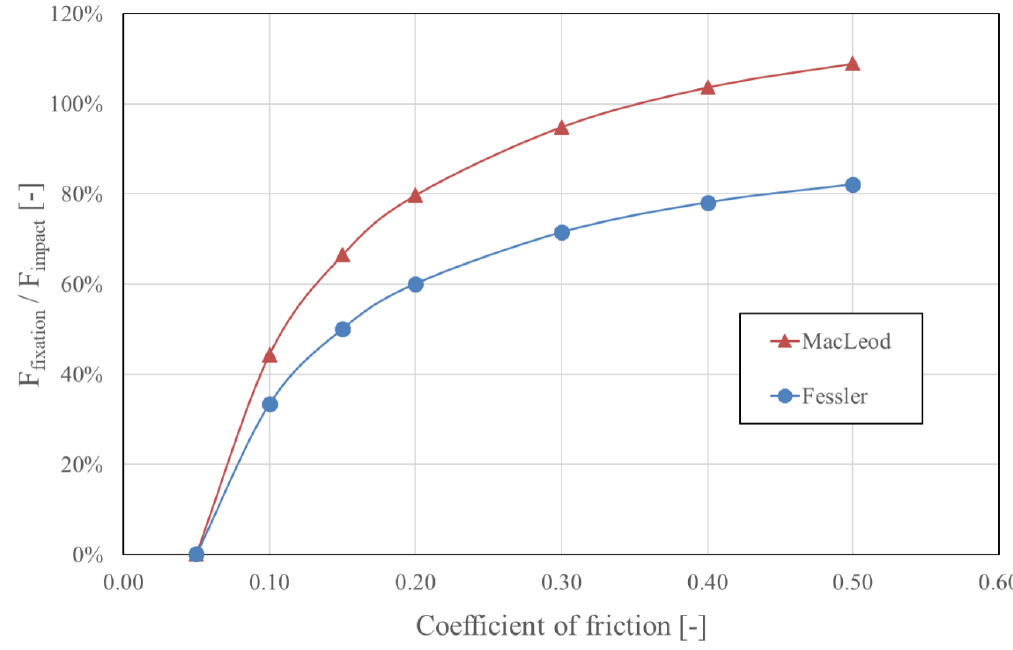
Figure 4. Influence of the coefficient of friction µ on fixation force, as estimated by Fessler and MacLeod’s models. For MacLeod’s model, a head diameter of 32 mm was considered. With the impaction force having a linear effect in both models, the fixation force is represented as a proportion of the impaction force. The effect of the coefficient of friction µ is not linear. With a coefficient of friction < 0.05, stable fixation is not possible. MacLeod’s model not only predicts higher fixation forces than Fessler’s model, it also predicts a fixation force higher than the impaction force starting from a coefficient of friction of 0.372 (for a 32-mm head) and upward, which is physically impossible.